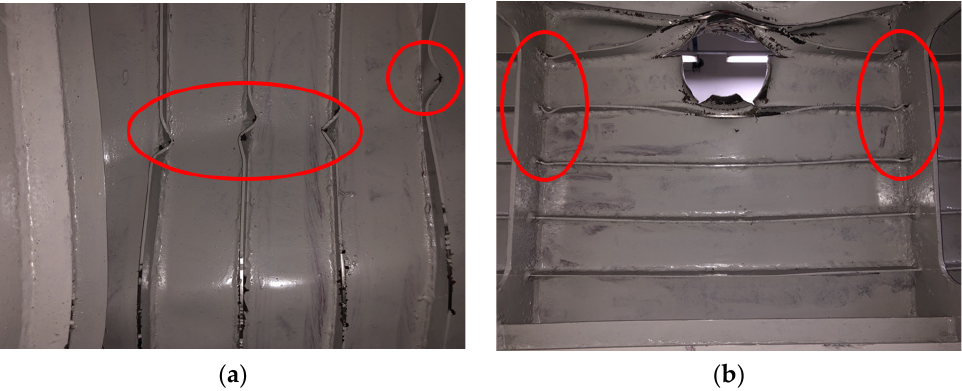
Figure 14. Deformed shapes of the longitudinal stiffeners—model DB-7: ( a ) deck; ( b ) damaged area.